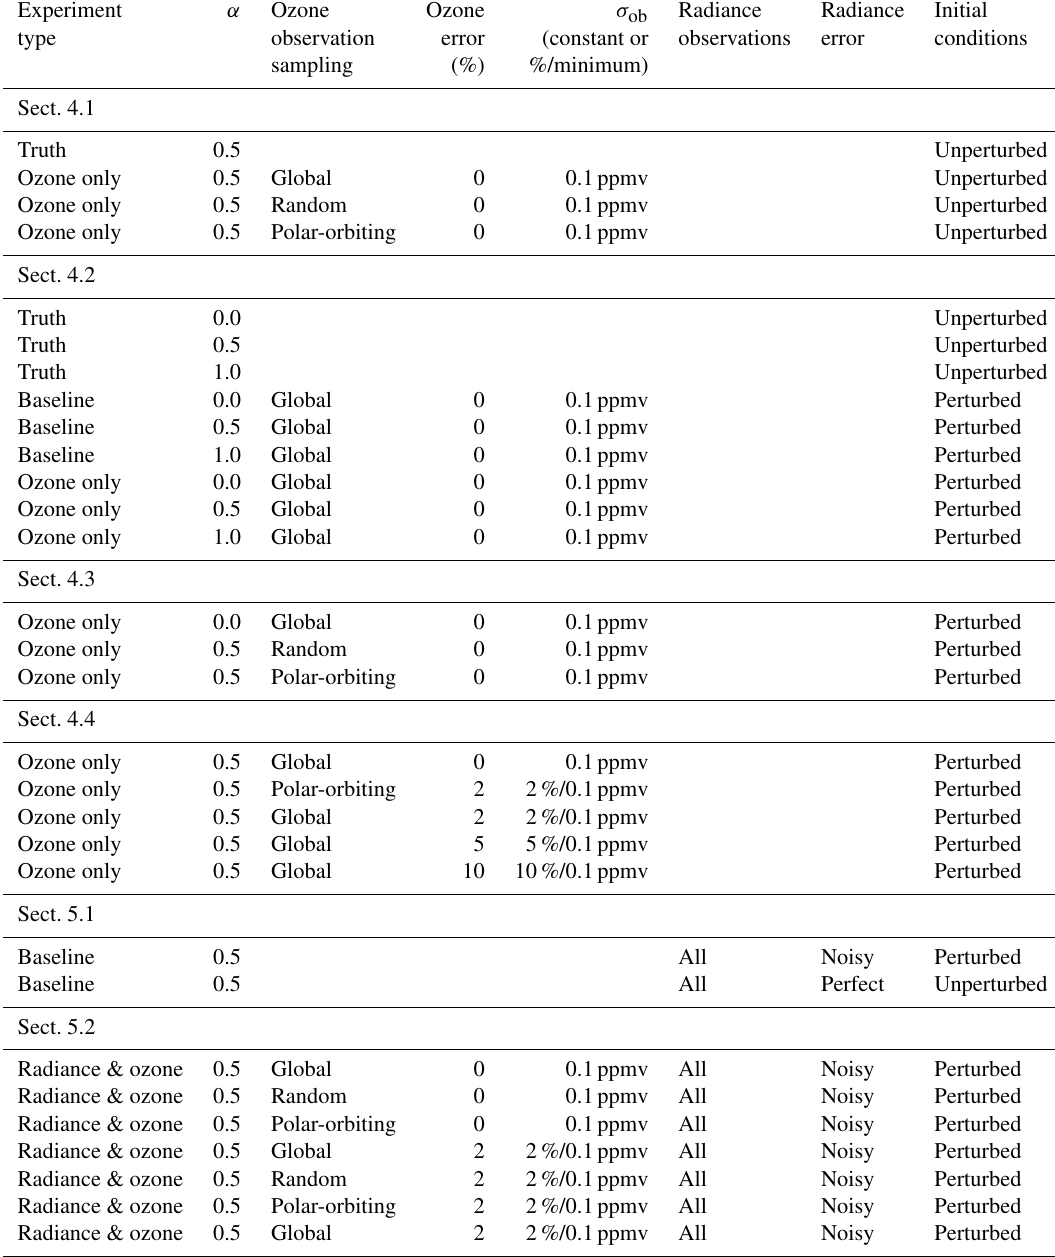
Table 1. Experiment descriptions used in each subsection of this study. Columns indicate (1) experiment type, (2) covariance blending value, (3) ozone observation sampling, (4) ozone observation error, (5) background ozone error standard deviation (given as constant mixing